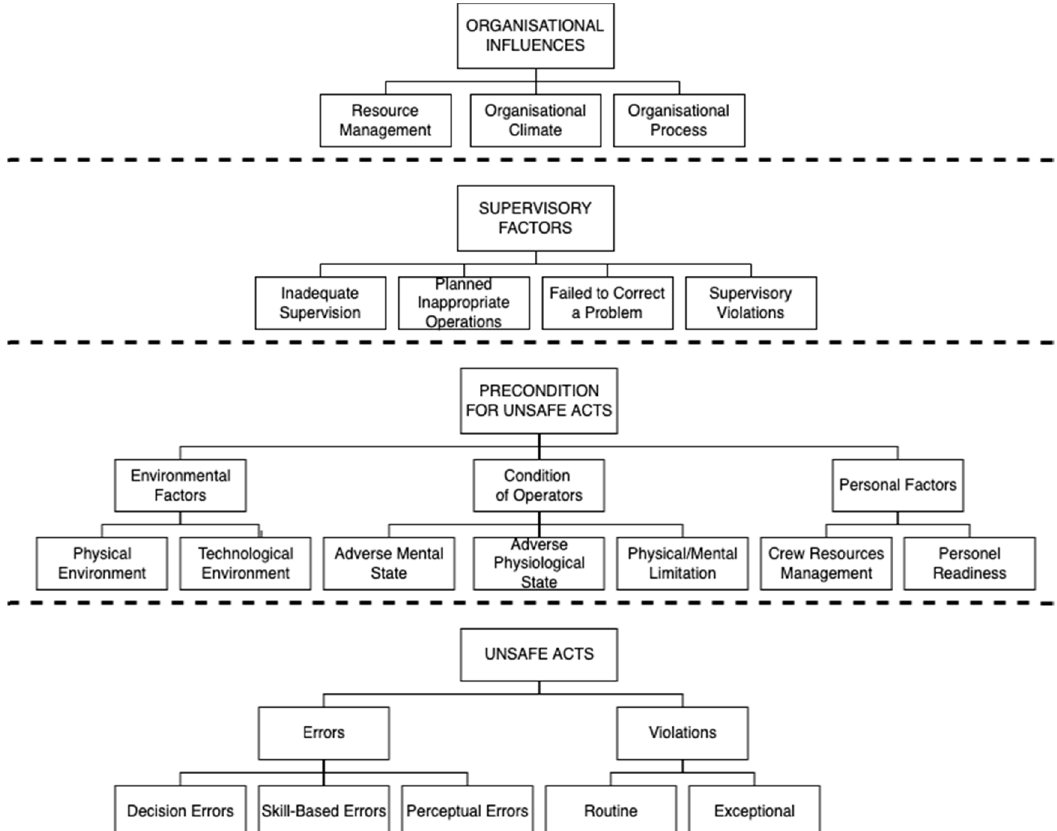
Figure 1: HFACS model [ 5 ]